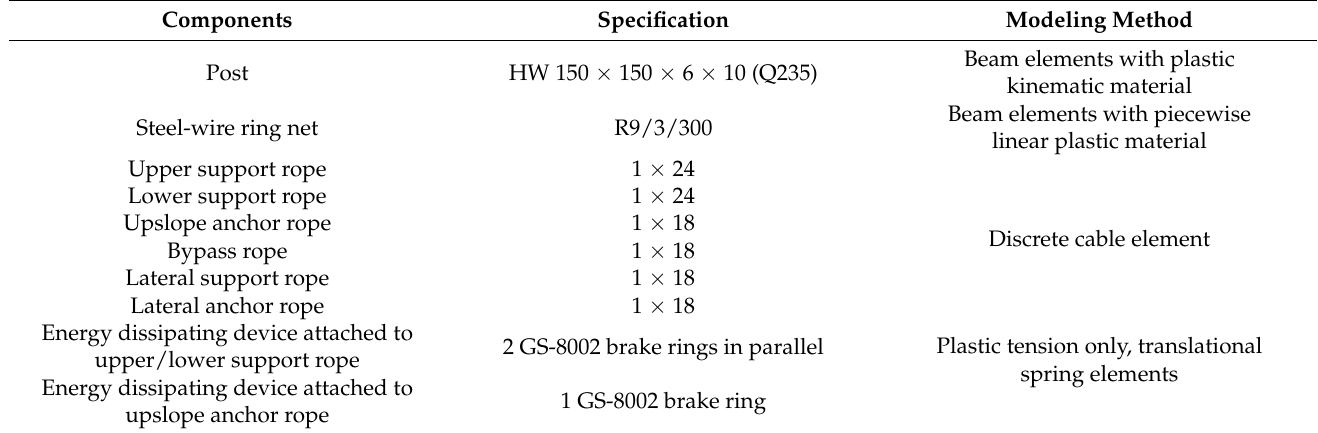
Table 2. Configuration and modeling method of the flexible